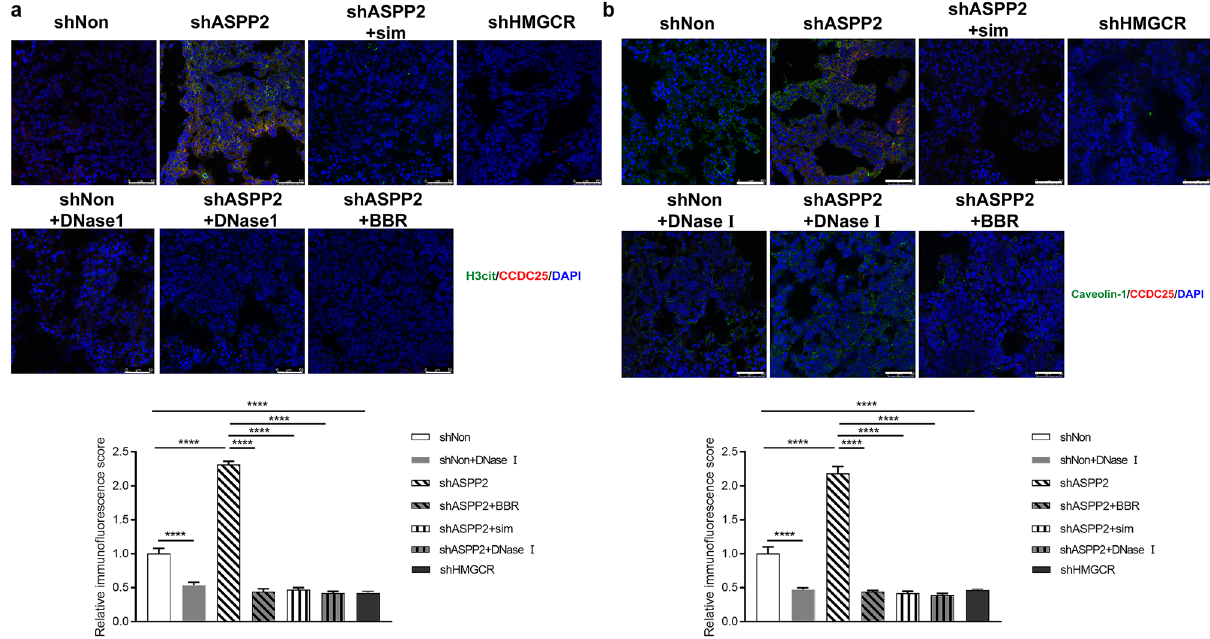
Figure 6. Inhibition of cholesterol biosynthesis reduces CCDC25 expression in lung metastases. ( a ) Images showed representative immunostaining for CCDC25 (red), H3cit (green) and DAPI (blue) in the lung metastases of indicated mice as in Fig. 4. Scale bar: 50 µm. ( b ) Images showed representative immunostaining for CCDC25, Caveolin-1 and DAPI in the lung metastases of indicated mice. Scale bar: 50 µm. Relative immunofluorescence scores were calculated and statistically analyzed. * P < 0.05; ** P < 0.01;*** P < 0.001.